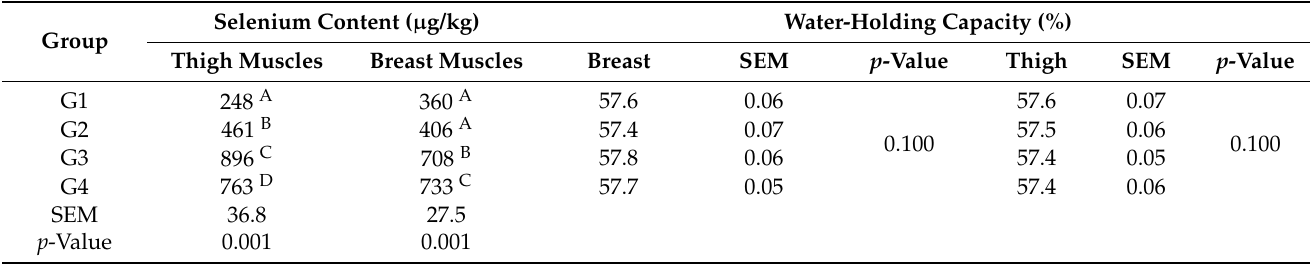
Table 6. Water-holding capacity and selenium content in the